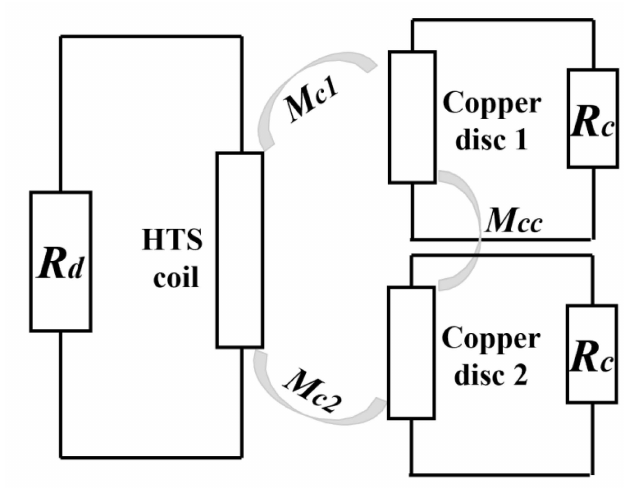
Figure 6. Schematic diagram for discharging tests of the HTS DP coil in the simulation.